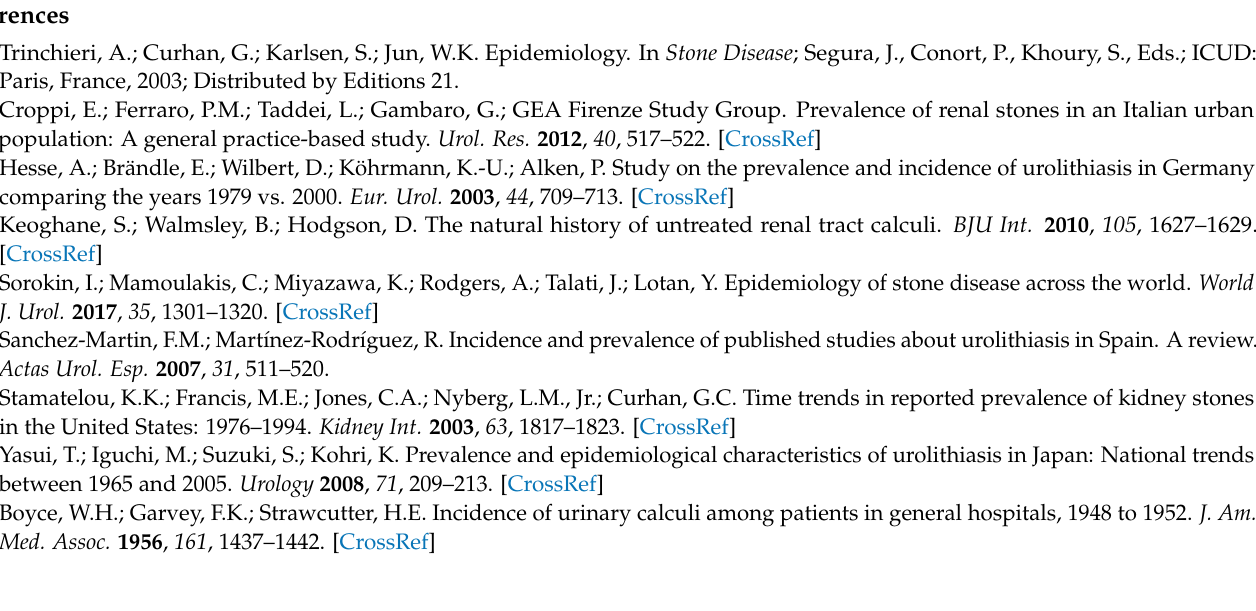
Table S5: Results for CODEm model testing; Table S6: Comparison of GBD 2016 and GBD 2019 covariates used and level of covariates; Table S7: Socio-Demographic Index groupings by location, based on 2019 values. References [42–46] are cited in the Supplementary